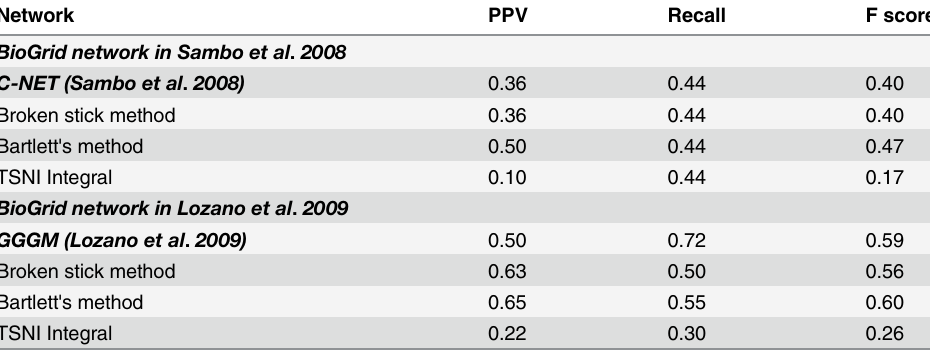
Table 6. Reconstruction of 9-gene BIOGRID network related to Human HeLa cell cycle. Network PPV Recall F score BioGrid network in Sambo et al . 2008 C-NET (Sambo et al . 2008) 0.36 0.44 0.40 Broken stick method 0.36 0.44 0.40 Bartlett's method 0.50 0.44 0.47 TSNI Integral 0.10 0.44 0.17 BioGrid network in Lozano et al . 2009 GGGM (Lozano et al . 2009) 0.50 0.72 0.59 Broken stick method 0.63 0.50 0.56 Bartlett's method 0.65 0.55 0.60 TSNI Integral 0.22 0.30 0.26 Recovery of 9-gene BIOGRID network involved in human HeLa cell cycle by applying broken stick and Bartlett ’ s feature selection methods compared to TSNI integral. These two versions of BIOGRID network were used to assess proposed methods in Sambo et al. 2008 and Lozano et al. 2009 respectively. Reported performance of these methods is also included.